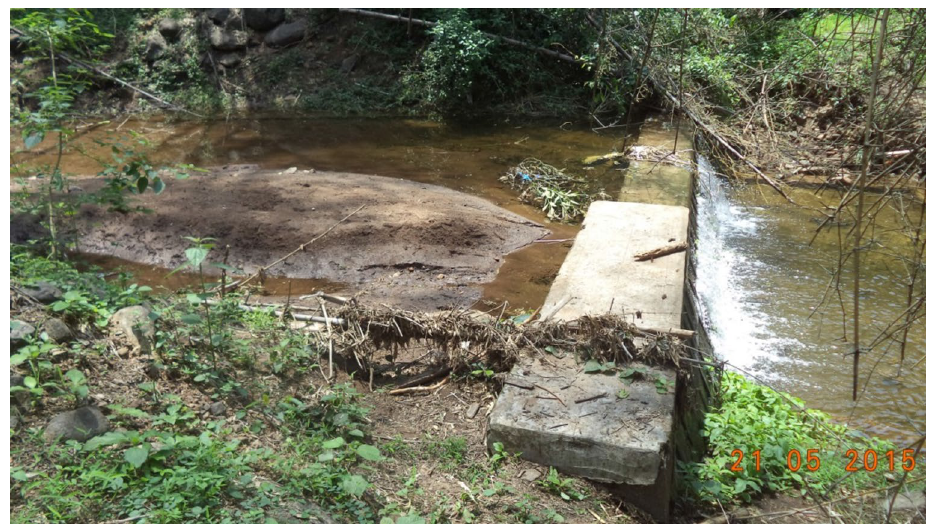
Fig. 13 Field photographs showing the Impact of a small Check Dam on Silt deposit in a non-perennial Stream at chinna manjavadi